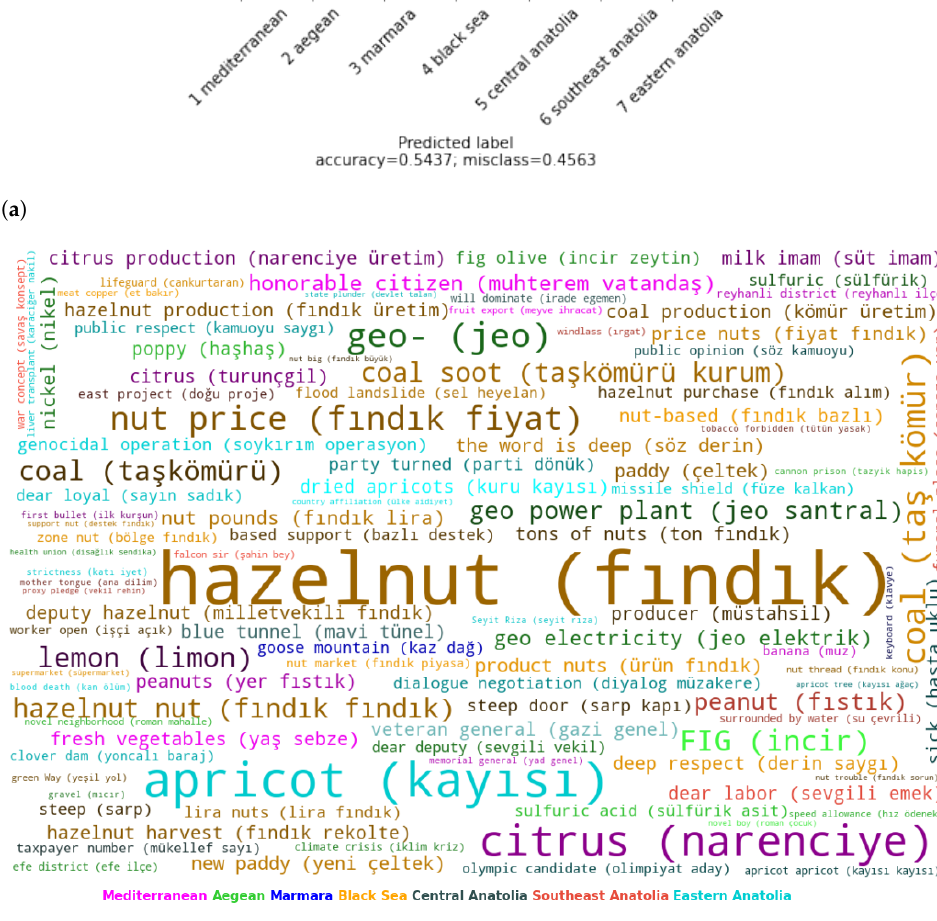
Figure 5. ( a ) Confusion matrix for region classification with TF-IDF (word) _LR. ( b ) Best terms of election region trait of